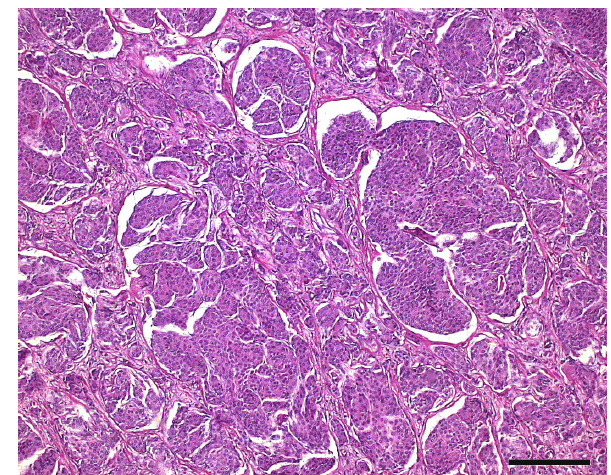
Figure 3. Histological photograph of a meningioma in an old pig- tailed macaque: meningothelial portion of the meningioma with is- lands of tumor cells separated by thin fibrous stroma. (hematoxylin– eosin, scale bar = 200µm)